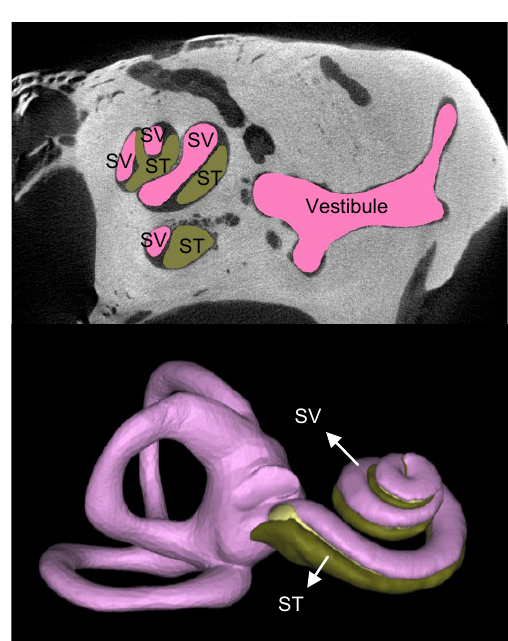
Fig. 5. Bony labyrinth.